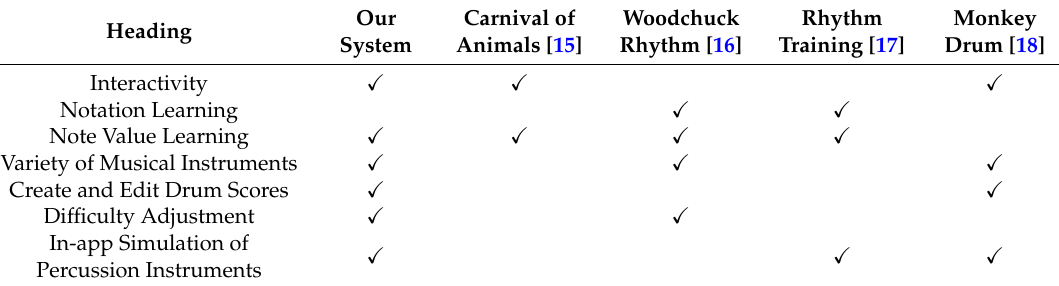
Table 3. Comparison of our system and four rhythm apps.